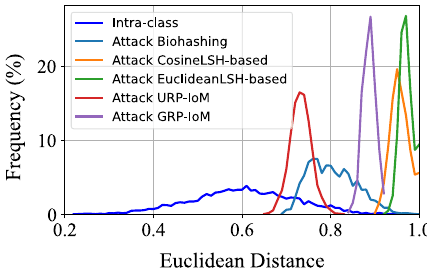
Fig. 12 Our proposed similarity-based attack results towards advanced cancelable biometrics schemes on CASIA-faceV5 database